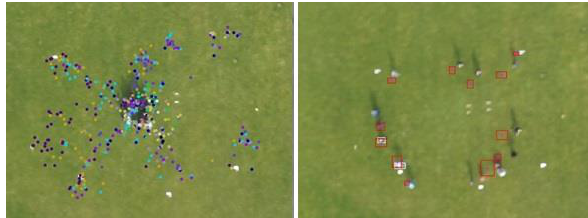
Figure 14. Result of the “Panic” scenario visualised with a point style on the left and a red frame during the processing on the right.